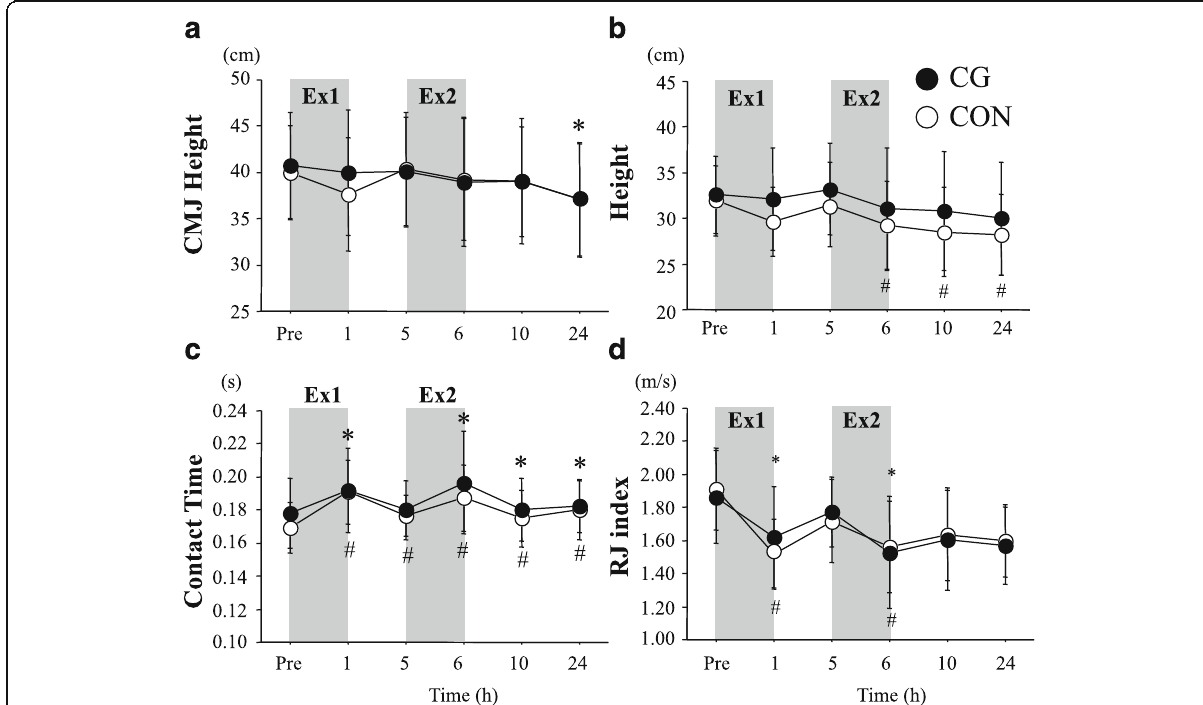
Fig. 3 Results of CMJ ( a ) and RJ ( b – d ). Height of CMJ ( a ) and height ( b ), contact time ( c ), and index ( d ) during RJ are presented here. Shaded boxes indicate duration of exercises. Values are means± SD. * P < 0.05 vs. Pre (CG); # P < 0.05 vs. Pre